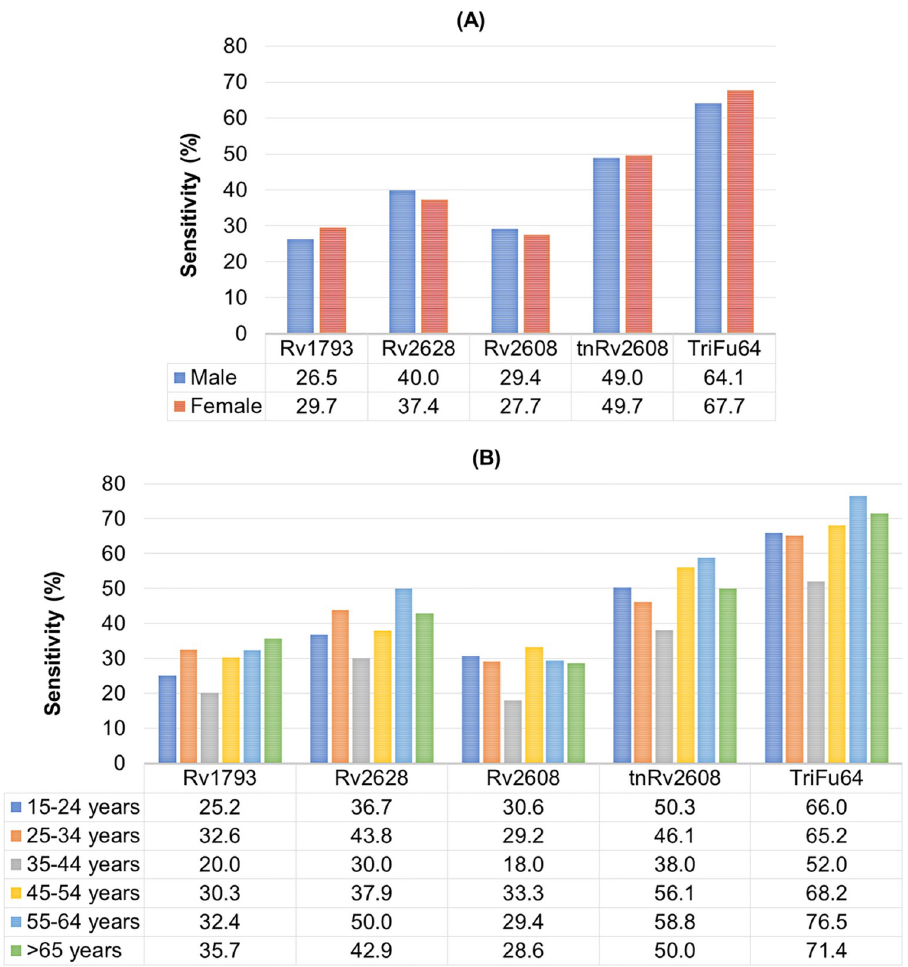
Fig 5. Comparison of sensitivities of single, truncated and fusion antigens among different groups of TB patients by (A) gender groups and (B) age groups.